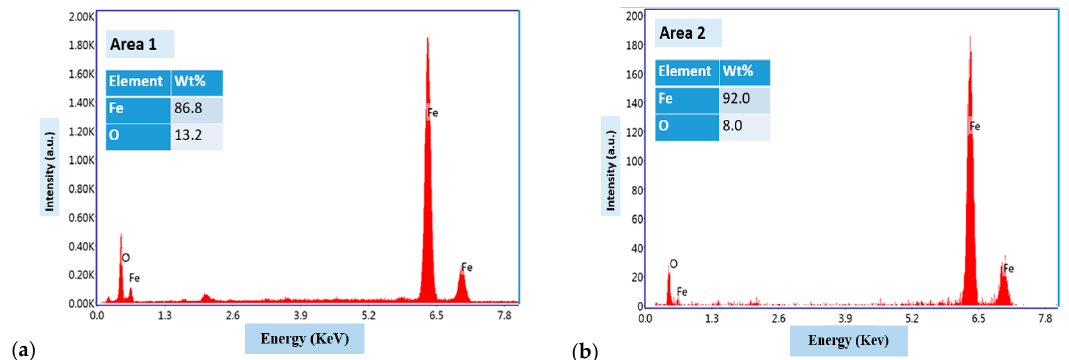
Figure 10. EDS analyses of ( a ) area 1 and ( b ) area 2, shown in Figure 9.